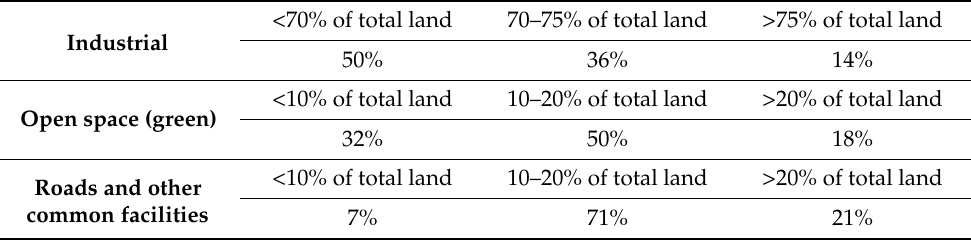
Integration into a Integration into a region with region with highway (existing highway (existing or under or under construction) and 2 construction), of the following: airport, port, and airport, port, or railway station train station 4% 22% 22% 52%